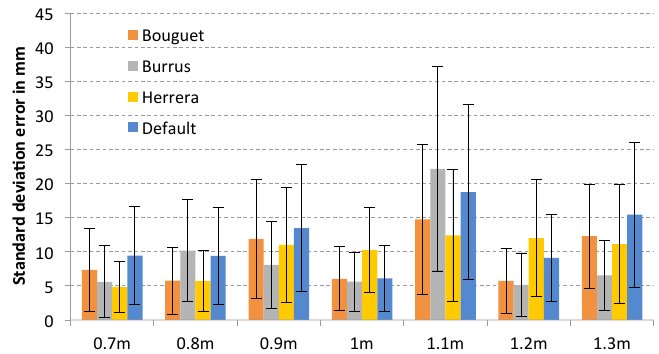
Figure 12. Plane fitting test error of each calibration method for Primesense Carmine 1.09.